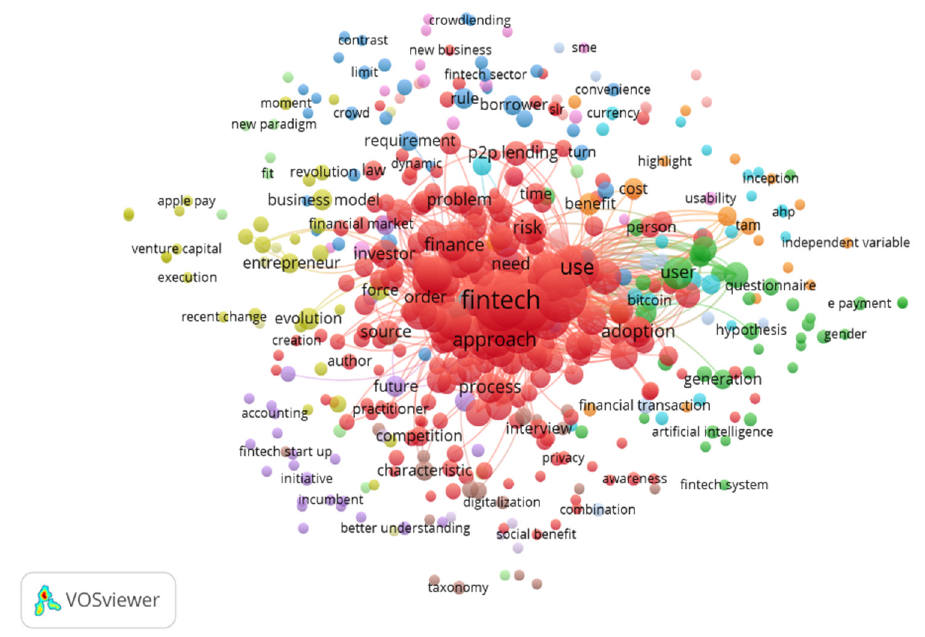
Figure 3. Result of content analysis using VOS Viewer.